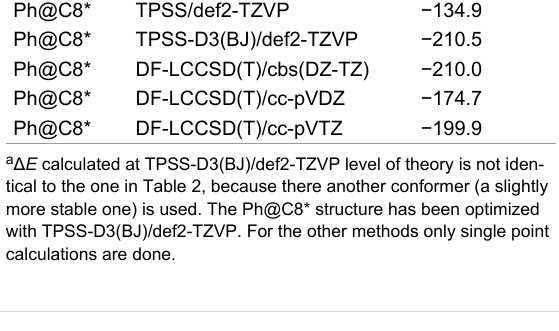
is strongly related to the experimentally investigated systems of Jiang et al. [16]. The only difference is that 1,4-diazanaphtha- lene groups of the host molecule are replaced by phenyl groups and the side chains of the anthracene bridge in the divalent host are neglected. In addition to the electronic contributions, enthalpic and entropic temperature effects as well as solvent effects are included in our simulations in order to compare to experimentally obtained Gibbs energy of association.